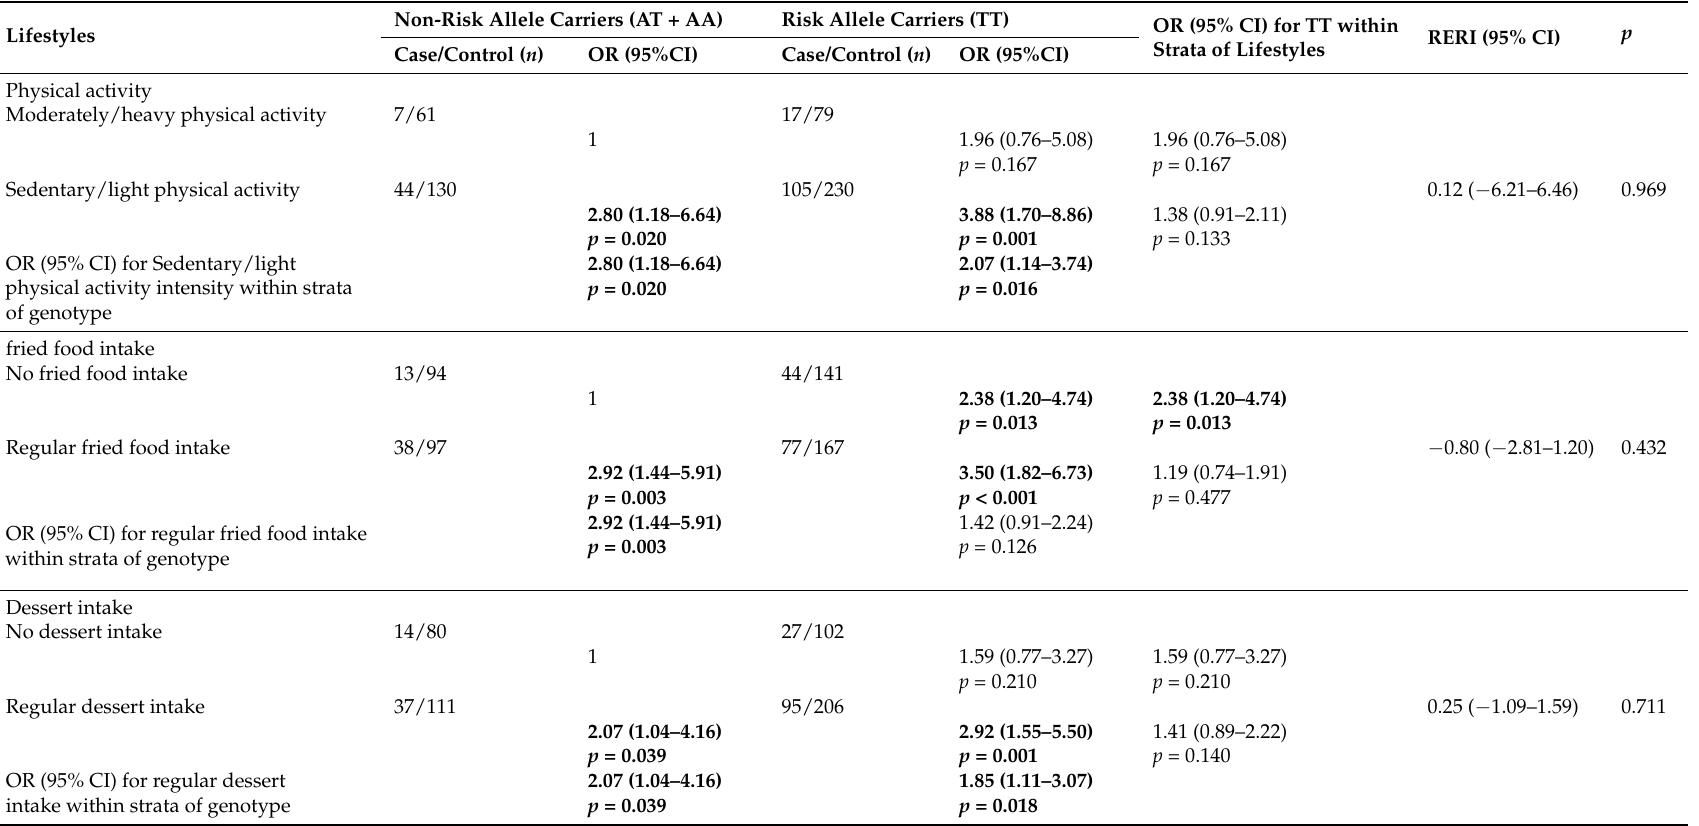
Table 3. Interaction between ABCA1 rs4743763 polymorphism and lifestyles for the risk of